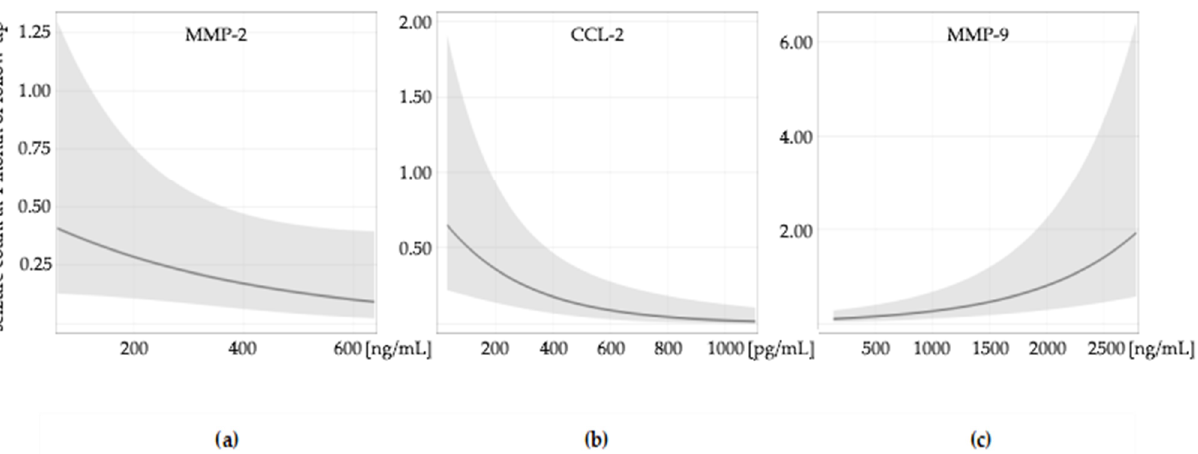
Figure 1. The influence of molecule levels on seizure count at one month of follow-up: ( a ) MMP-2; ( b ) CCL 2; ( c ) MMP 9. The influence of molecule levels on seizure count at seven days, 3, 6, and 12 months are shown in Figure S2.